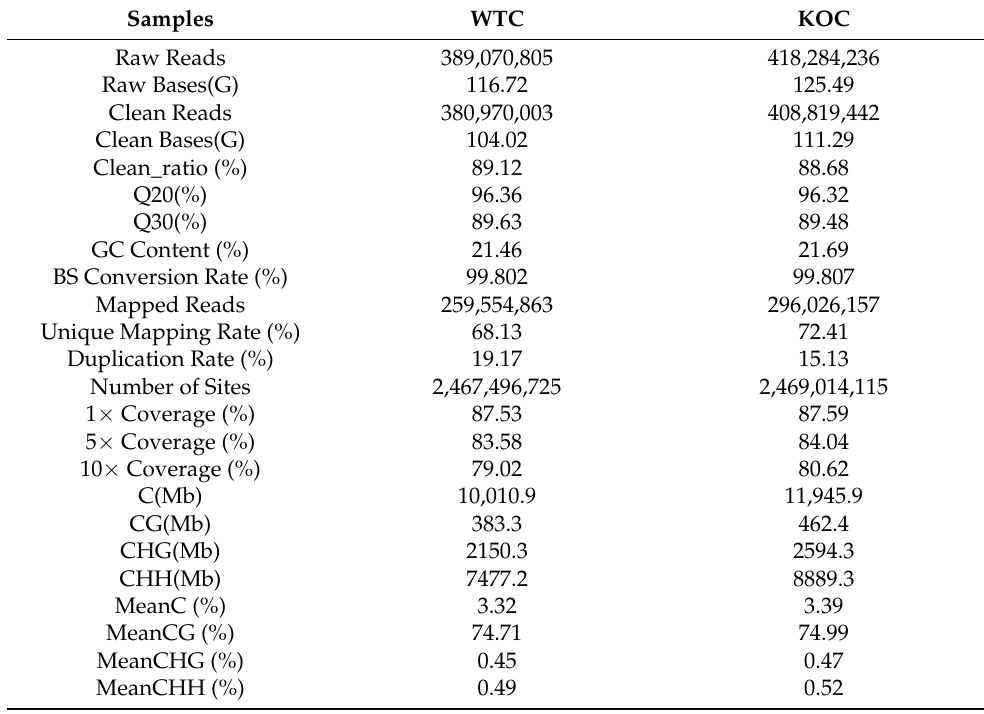
Table 1. The overview of output data by Whole-Genome Bisulfite